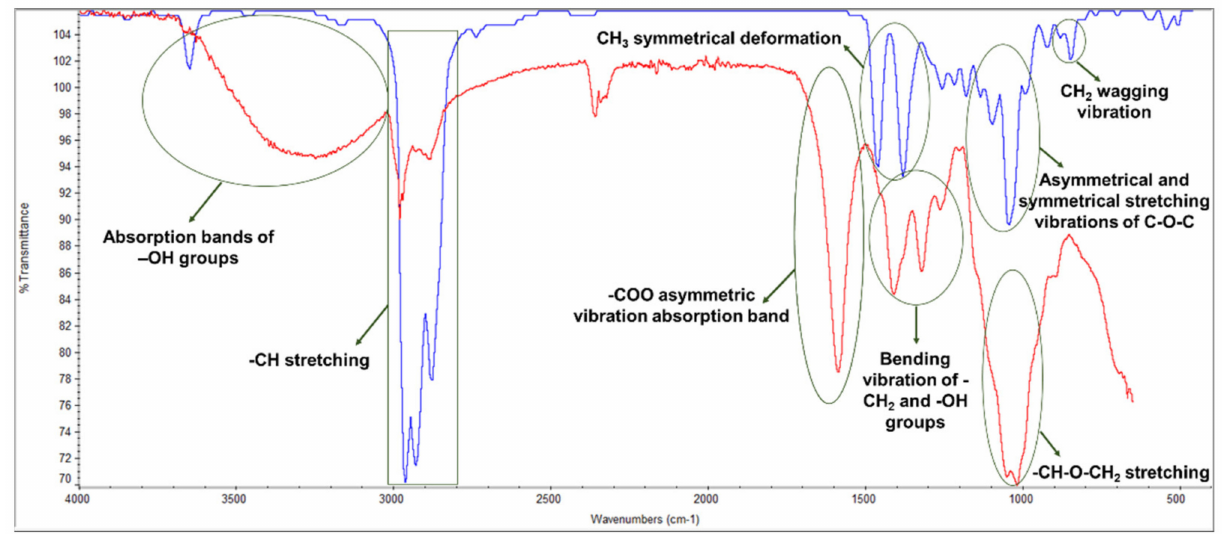
Figure 6. FTIR-ATR spectrum of CMC (red) and EO